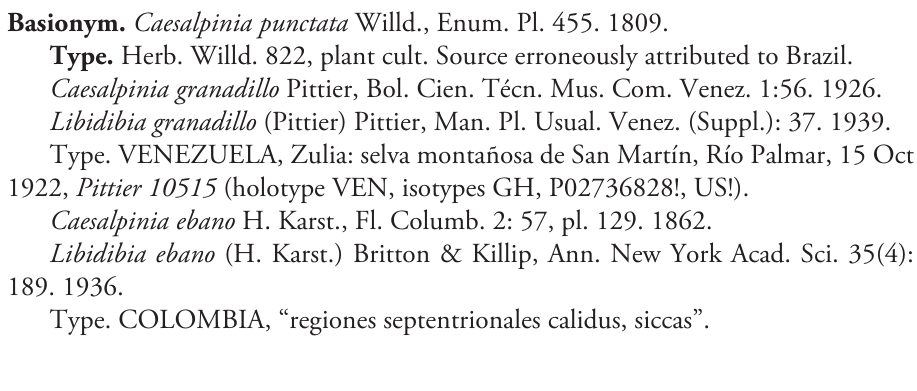
Type. Balsamocarpon brevifolium